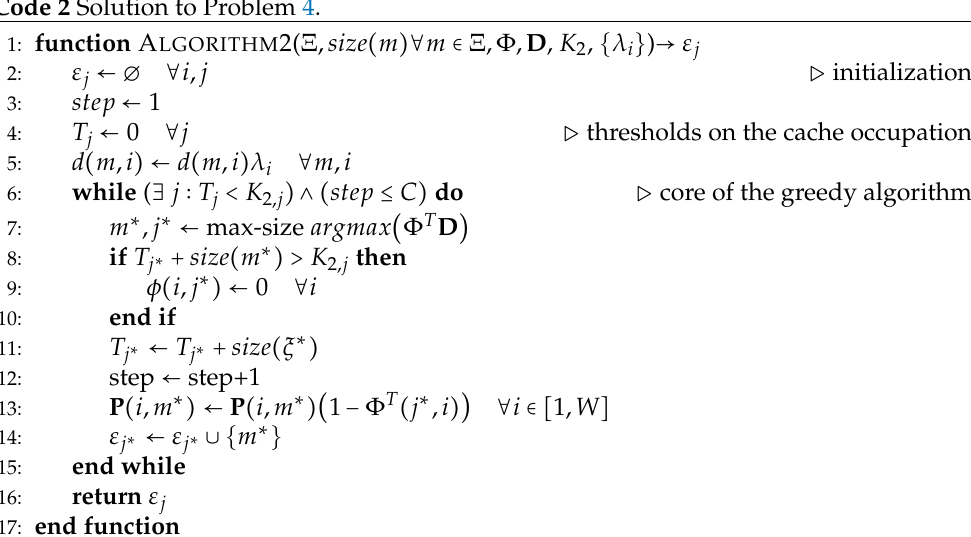
Code 2 Solution to Problem